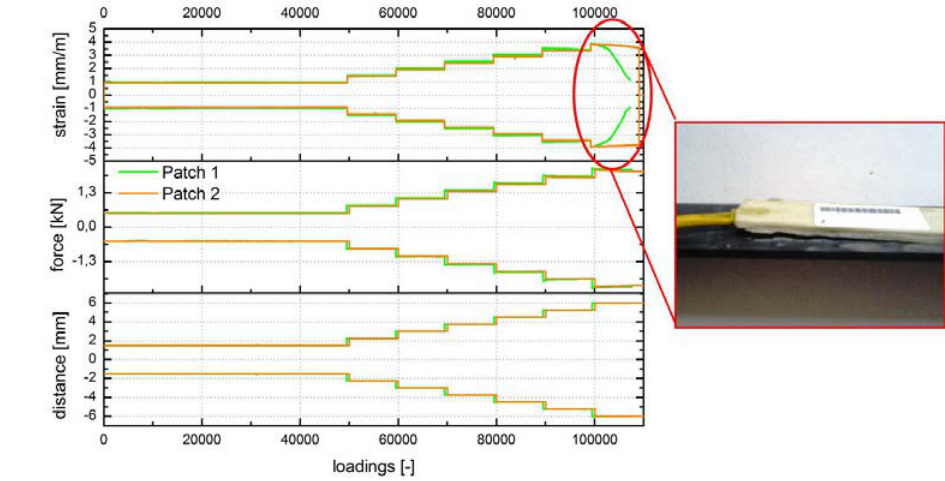
Figure 1. Alternate bending test with FBG-based patches. The optical signal of patch 1 decays at a flexural strain of 4 mm/m. The patch started to delaminate from the